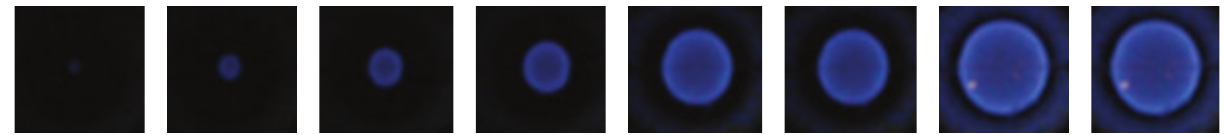
Figure 7: Typical growing image of flame radius for hydrous ethanol-air (95.5%v). Time interval: 2.381 ms ( 𝜙 = 1.1 , 𝑇 = 305 K, and 𝑃 = 1 atm).